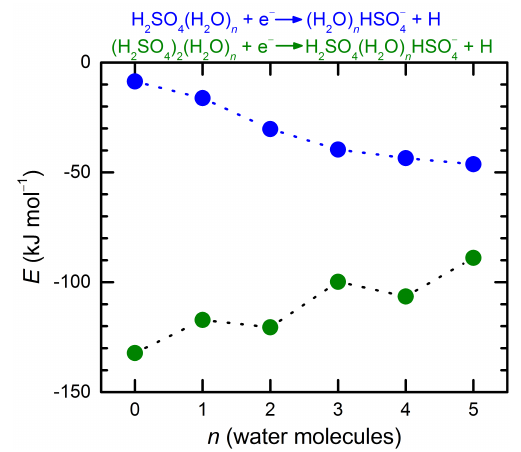
Figure 5. Reaction energies for the HSO − after electron attachment to H 2 SO 4 /H 2 O clusters optimized at the M06-2X/aug-cc-pVDZ level of